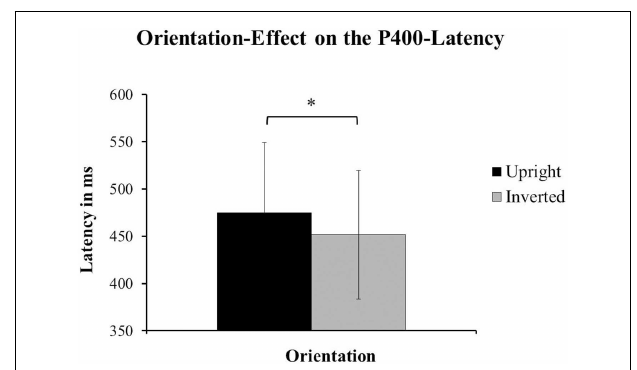
the amplitude of the P400; F (1, 14) = 5.393, p = 0.036. In our